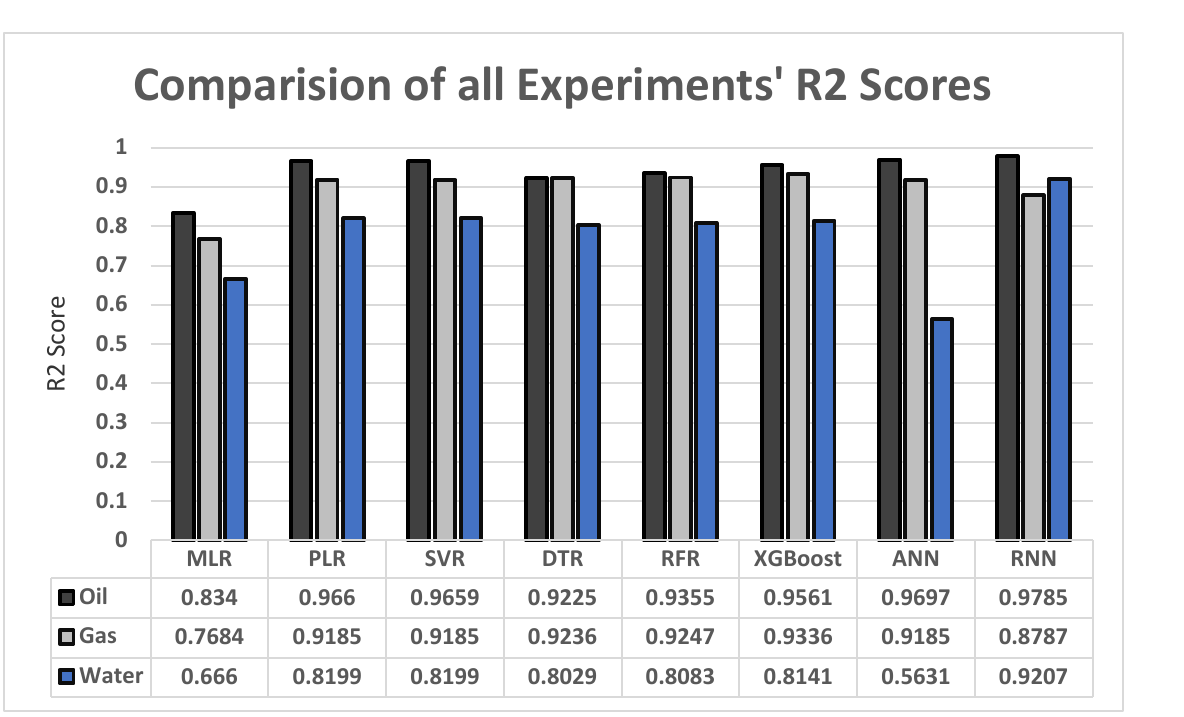
Figure 12. All models’ R2 score results comparision.